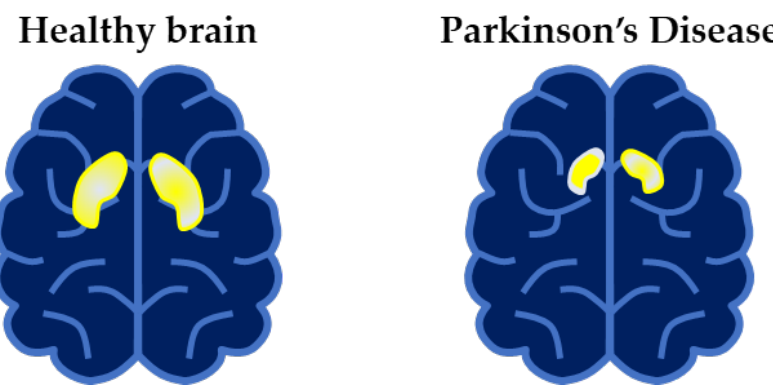
Figure 2. Schematic drawing of Single-photon emission compute tomography (SPECT) scan of (left) healthy controls and (right) PD patients. Availability of dopamine transporters (DAT) in the striatum represented by the highlighted portion in the brain.